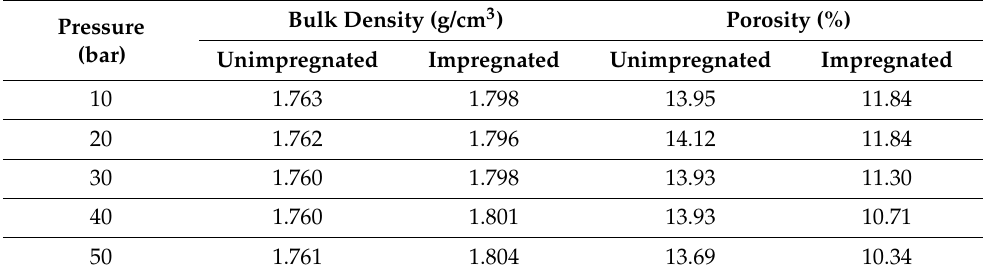
Table 2. Bulk densities and open porosities of graphite block before and after impregnation. Pressure